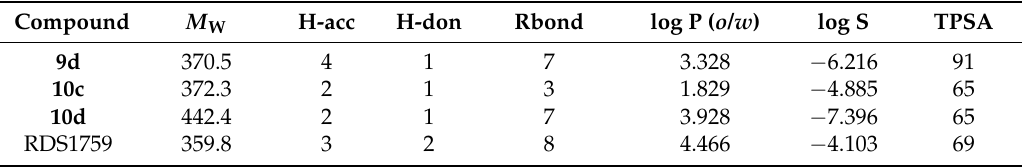
Table 2. Predicted physicochemical/ADME properties for compounds 9a – d , 10a – d , and RDS1759. Compound M W H-acc H-don Rbond log P ( o / w ) log S